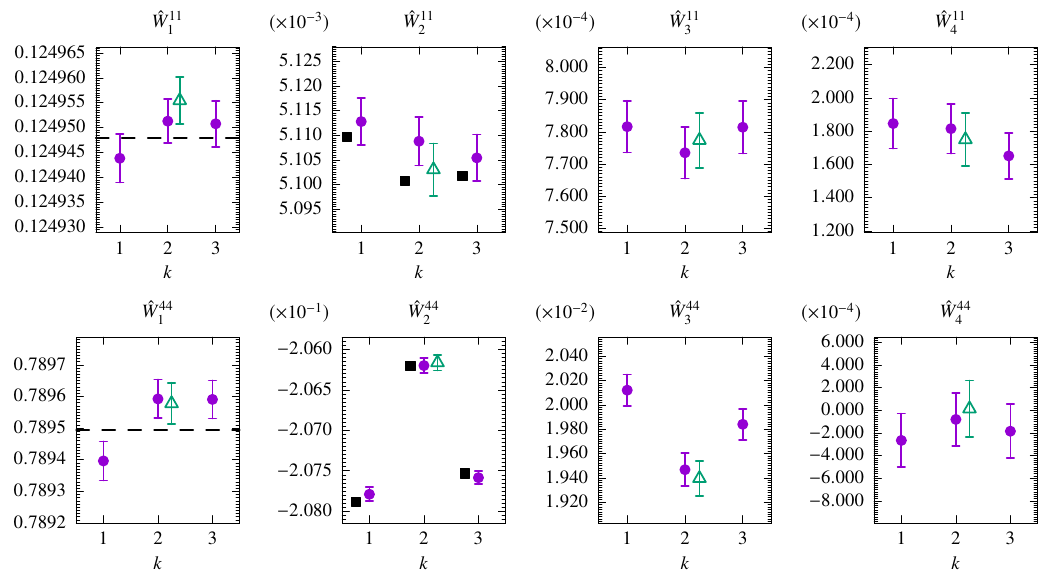
Figure 3. k dependence for ^ W 11 to 1 =N MD ! 0 and the other values are at N MD = 32. Dashed line in ^ W RR ^ W RR